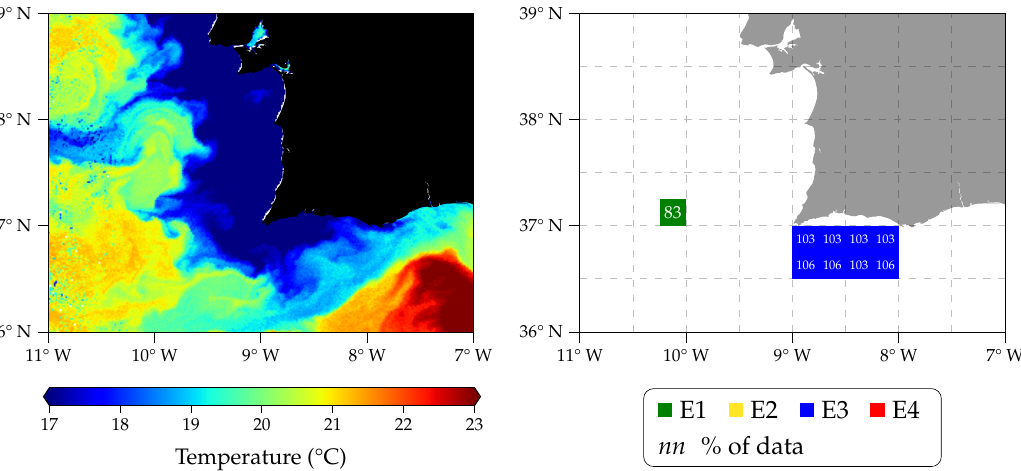
Figure 10. Left : event of 16 September 2017, classified as E1 in the ground truth (but images with events classified as E3 are present around that day in the dataset). Right : heatmap generated by MEC. The figures are cropped to the area between 36° and 39° N and between 11° and 7° W for a better